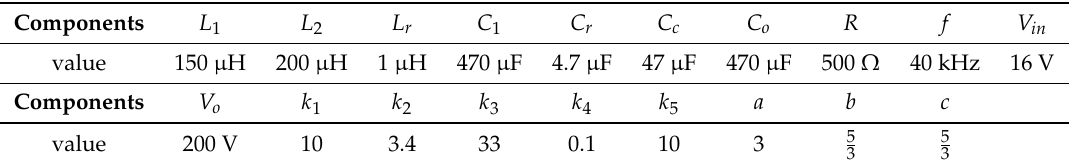
Table 2. Related parameters of this